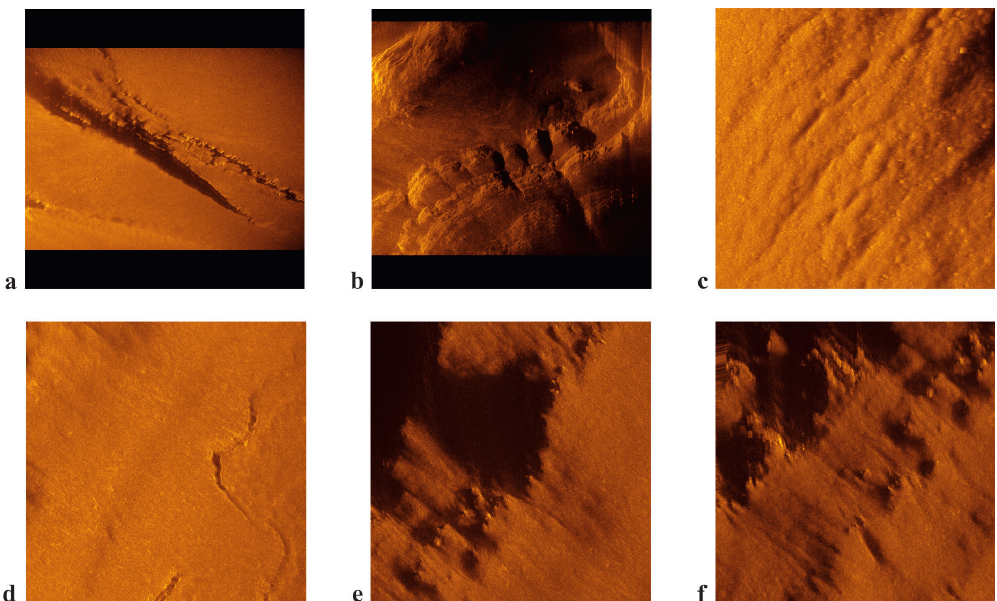
Figure 10. Examples of images created by spot-processing technique in REFLECTIONS software. ( a ) Fault structure at the depth of 1556. 09 m (36 ◦ 38.270 (cid:48) N, 022 ◦ 05.476 (cid:48) E). ( b ) Steep rocky slope at the depth of 1742.14 m (36 ◦ 38.369 (cid:48) N, 022 ◦ 05.197 (cid:48) E). ( c ) Sediments structure at the depth of 1357.76 m (36 ◦ 38.990 (cid:48) N, 022 ◦ 05.149 (cid:48) E). ( d ) Cracks at the depth of 1544.25 m (36 ◦ 38.290 (cid:48) N, 022 ◦ 05.373 (cid:48) E). ( e ) Rocky sea floor at the depth of 1558.70 m (36 ◦ 38.279 (cid:48) N, 022 ◦ 05.345 (cid:48) E). ( f ) Rocky sea floor at the depth of 1546.18 m (36 ◦ 38.265 (cid:48) N, 022 ◦ 05.368 (cid:48) E). Images in ( a , b ) present 100 m by 100 m areas of the seafloor, while all others are generated for 50 m by 50 m subsection.